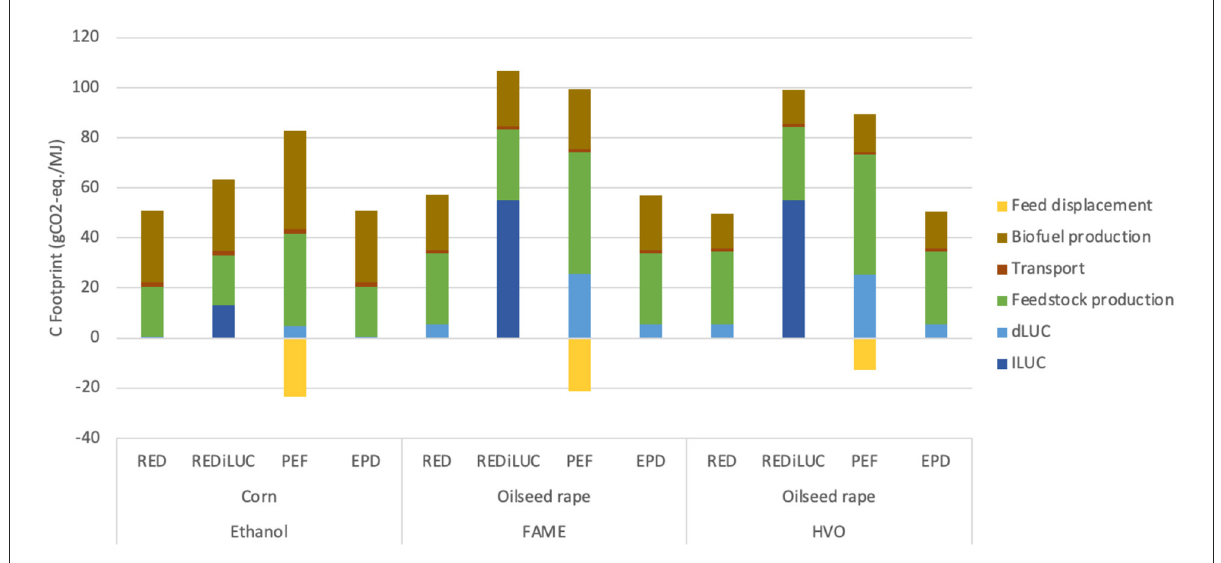
FIGURE3 System boundaries in relation to the methods applied: RED II, PEF, and EPD.